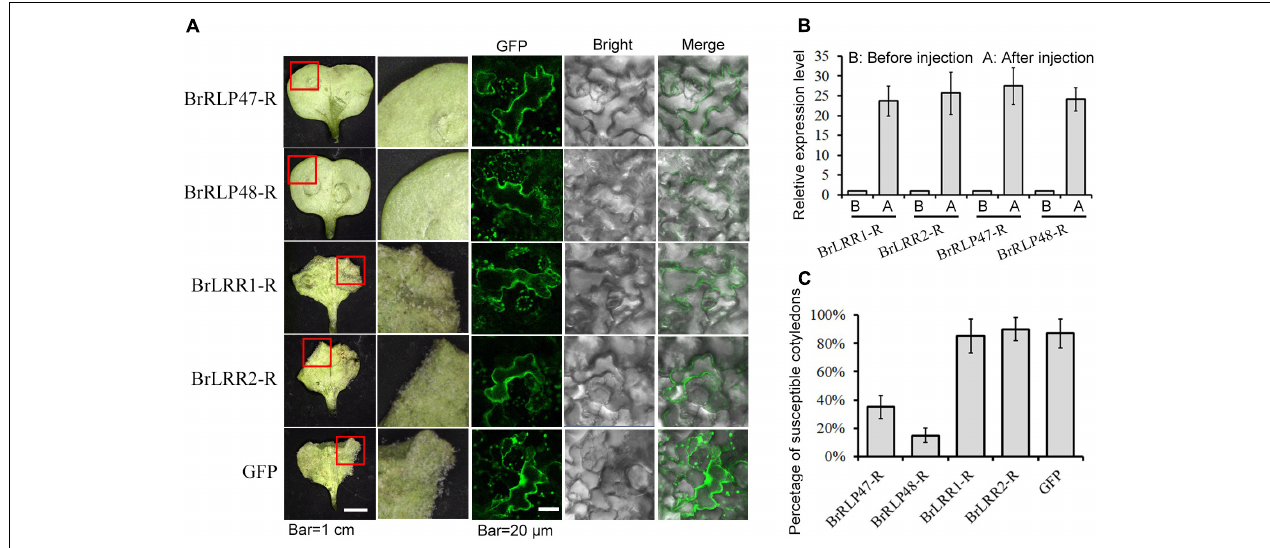
FIGURE 2 | Functional analysis of resistance candidate genes in a transient expression system mediated by agroinfiltration. (A) The disease resistance phenotypes and protein expression assay of cotyledons injected with BrLRR1-GFP , BrLRR2-GFP , BrRLP47-GFP , BrRLP48-GFP , and GFP alone were observed 3 days after agroinfiltration. The images in red squares are magnified in the pictures in the second column from the left. (B) Gene expression analysis after agroinfiltration. Five to ten leaves were pooled in a single sample in each replicate. Expression of each gene before injection was defined as 1.0. Values represent means ± SD ( n = 3) from three biological replicates. (C) The percentage of susceptible injected cotyledons after inoculation. Values represent means ± SD from four independent experiments. Each experiment tested at least 50 cotyledons.